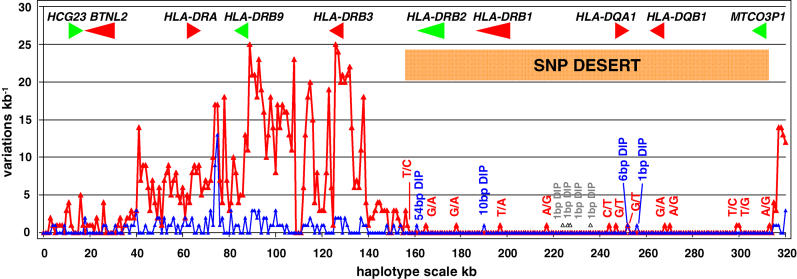
Positional Distributions of Variations between COX and QBL in the HLA-DR RegionMHC sequences were divided into 10-kb bins, and variations were calculated in each bin. Results are expressed as variations per 1 kb. Red and blue plots relate to SNP and DIP variations respectively.Within a stretch of approximately 160 kb between HLA-DRB3 and HLA-DQB3, only 14 SNPs and six small DIPs, comprising 1 bp, 6 bp, 10 bp (five copies of a dinucleotide repeat), and 54 bp (two copies of 27 mer), were contained. None of the variations located to coding sequence or the defined promoter regions of the HLA class II genes [86].Four 1-bp DIPs, labelled in grey, were identified between DRB1 and DQA1 where LR-PCR products were used to close a small gap resulting from clone deficit. These DIPs were located in polyA/T tracts in which the probability of Taq slippage in PCR products is much higher than in in-vivo amplified plasmid DNA such that their authenticity was questionable and they were excluded from analyses (Figure S2 shows one alignment of sequence traces with differing polyT tracts).